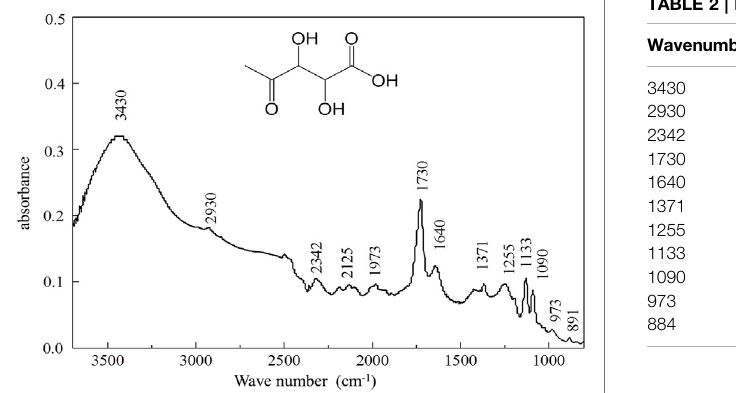
Figure 6 . A comprehensive interpretation of FTIR spectra was tabulated in Table 2 , which summarized the detailed assignment of spectral bands for DHOPA.